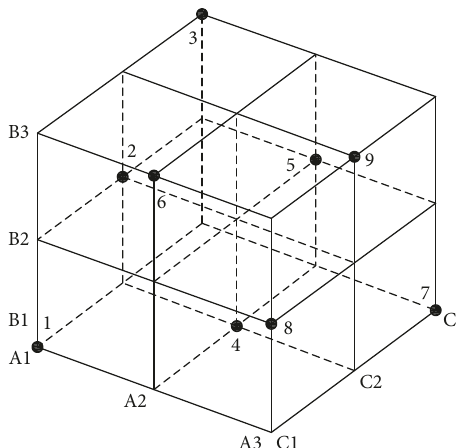
Figure 15: Diagrammatic sketch for orthogonal design. The black dots are the combinations of values of the permeability coefficients for materials A, B, and C Three values of permeability coefficient for each material are